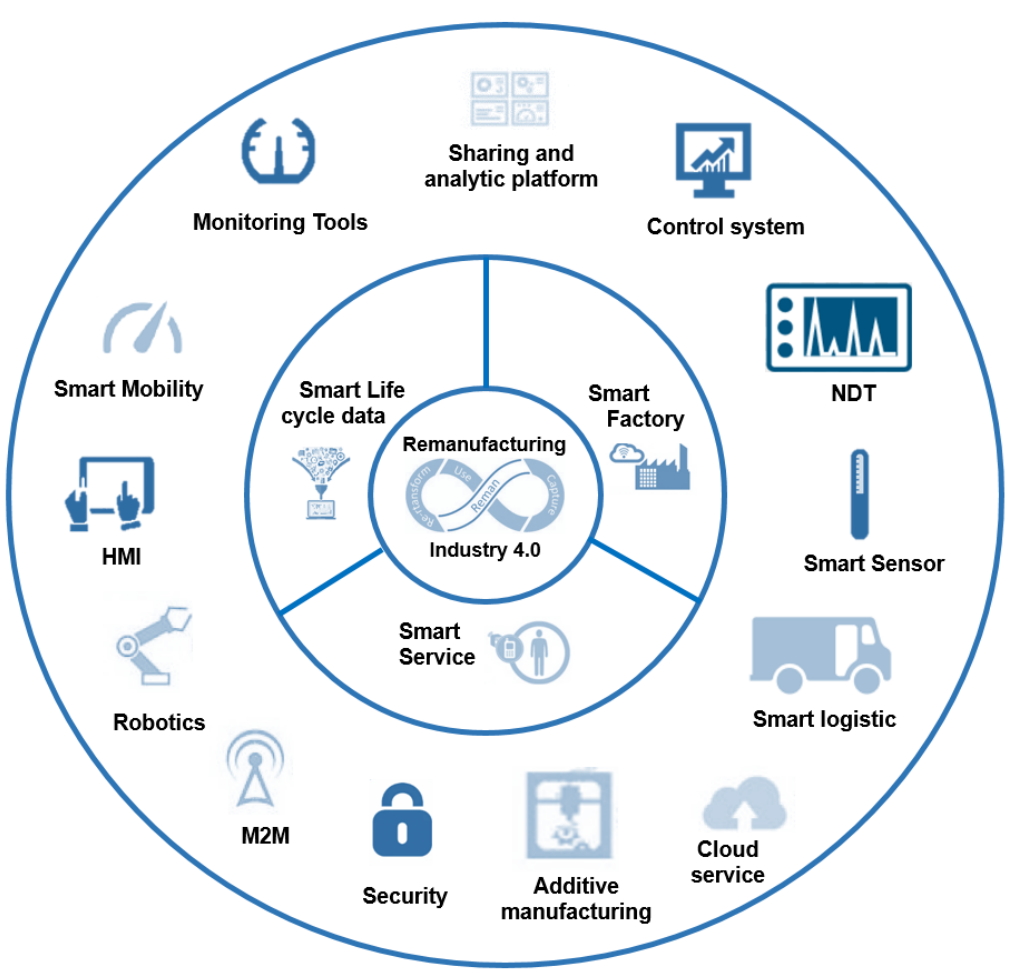
Figure 1. Opportunities from Industry 4.0 for remanufacturing, and its key enablers.